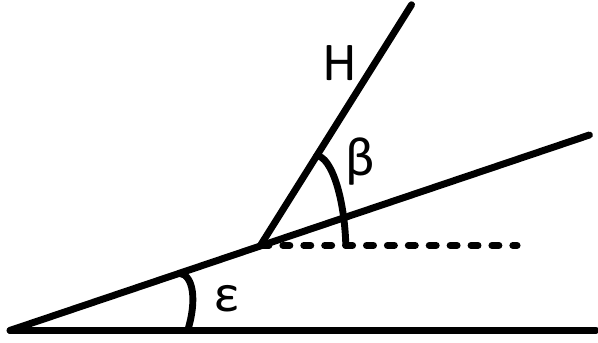
Figure 3. Single collector deployed on a sloped plane.